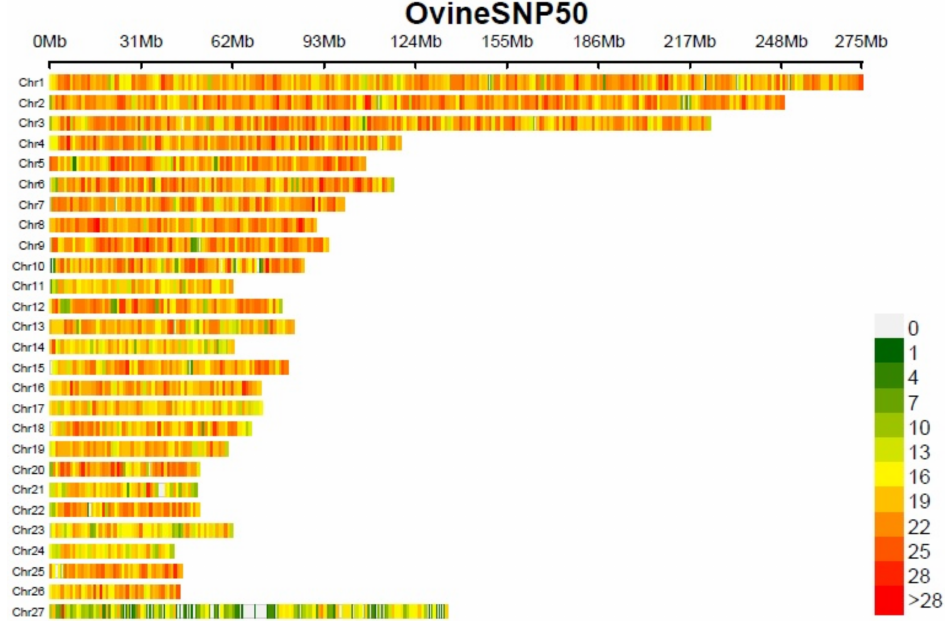
Figure 1. Density of the markers in the 27 chromosomes of the Pelibuey sheep. The color gradient has been scaled considering all markers in ROH, i.e., green color for low density and red color for high